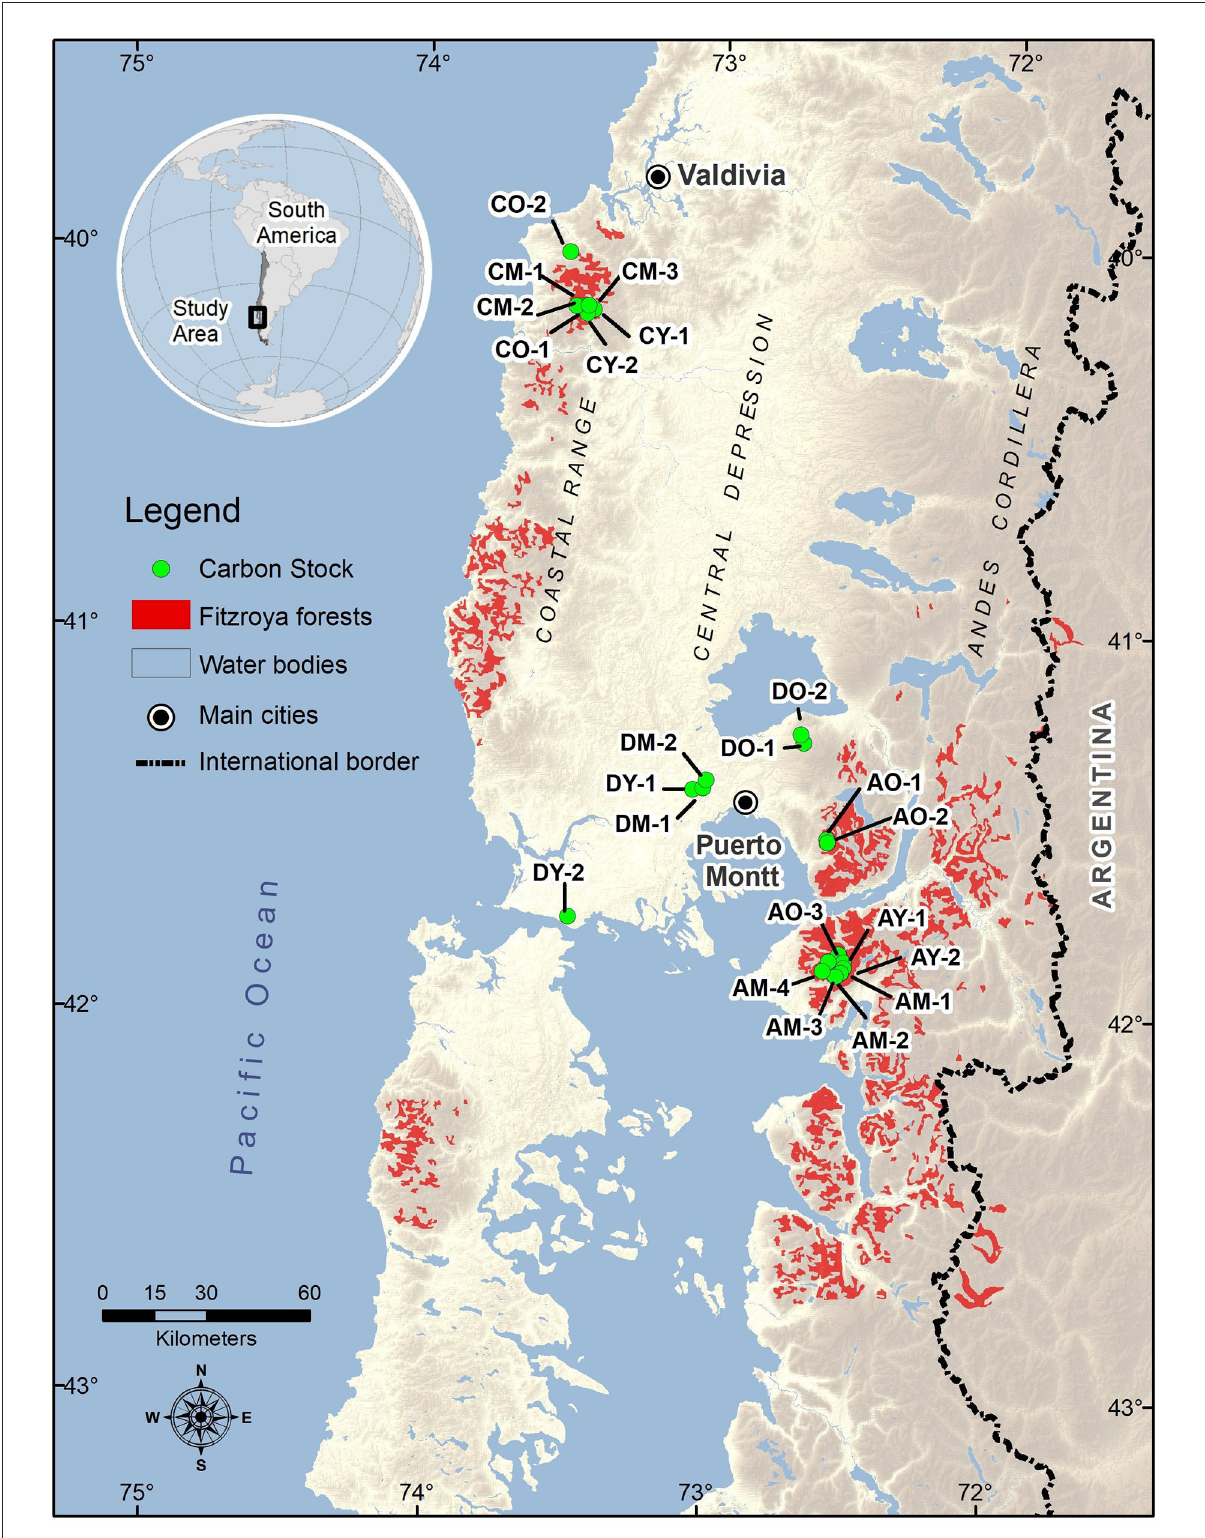
FIGURE1 Study sites of Fitzroya cupressoides stands in the Coastal range, Central depression, and Andean range in south-central Chile. Stand codes and the main attributes for each stand are given in Supplementary Tables S1, S2. Map credit: Aldo